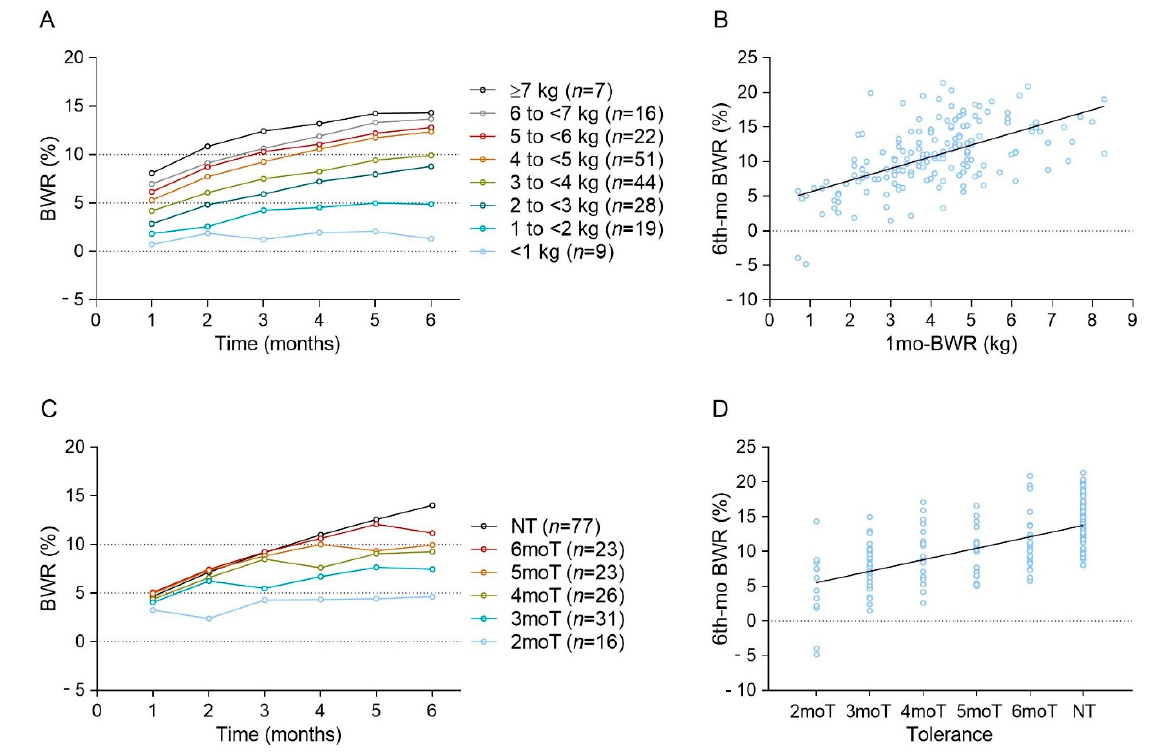
Figure 2. Six-month trends of mazindol effect on the body weight reduction according to body weight loss in kilograms during the first month (1mo-BWRkg, Panel A ) and month of tolerance (Panel C ). In Panels A and C each point represents the mean. Standard deviations were omitted to allow visualization of overlapping traces. Correlation curves between 1mo-BWRkg (Panel B ) or month of development of tolerance to mazindol (Panel D ), with 6mo-BWR%.